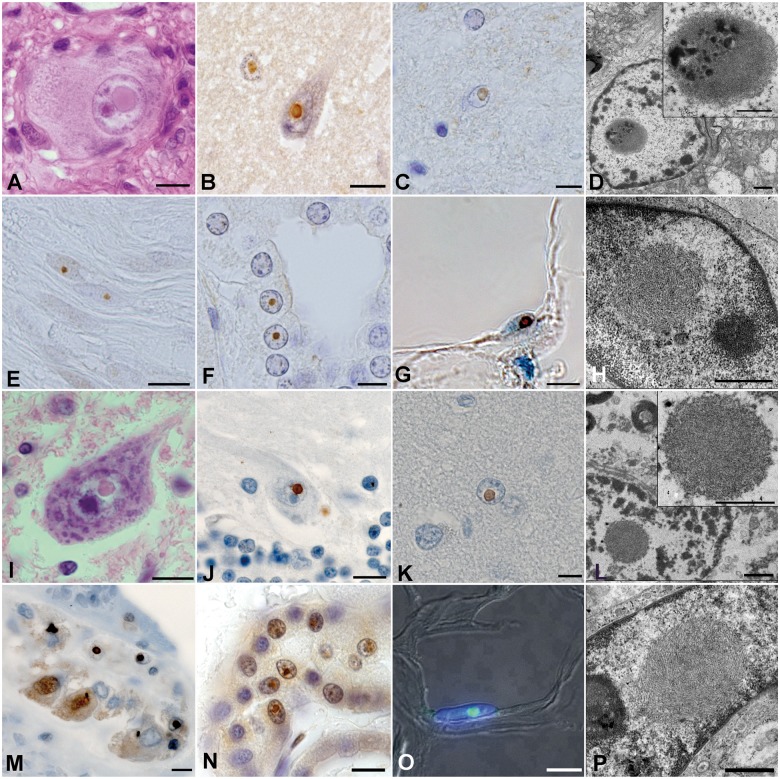
Histopathological findings of NIID cases. (A–H) Sporadic NIID cases. (I–P) Familial NIID cases. (A and I) Haematoxylin and eosin stain of sympathetic ganglion of Subject S-31(A) and spinal cord motor neuron of Subject F2-1 (I). (B, C, E, F, J and M–O) Immunostained samples with anti-ubiquitin antibody of temporal cortex neuron of Subject S-31 (B), cingulate gyrus astrocyte of Subject S-5 (C), dorsal root Schwann cells of Subject S-31 (E), renal tubule cells of Subject S-5 (F), Perkinje cell of Subject F1-2 (J), myenteric plexus neuron of Subject F1-1 (M), renal tubule cells of Subject F2-1 (N), adipocyte of Subject F3-1 (O). (G and K) Immunostained samples with anti-p62 antibody of adipocyte of Subject S-1 (G) and astrocytes of Subject F1-2 (K). (D, H, L and P) Electron microscopic images of astrocyte of Subject S-31 (D), skin fibroblast of Subject S-31 (H), astrocyte of Subject F1-2 (L), and skin fibroblast of Subject F5-1(P). Scale bars in A–C, E–G, I–K and M–O = 10 μm; in D, H, L and P = 1 μm.